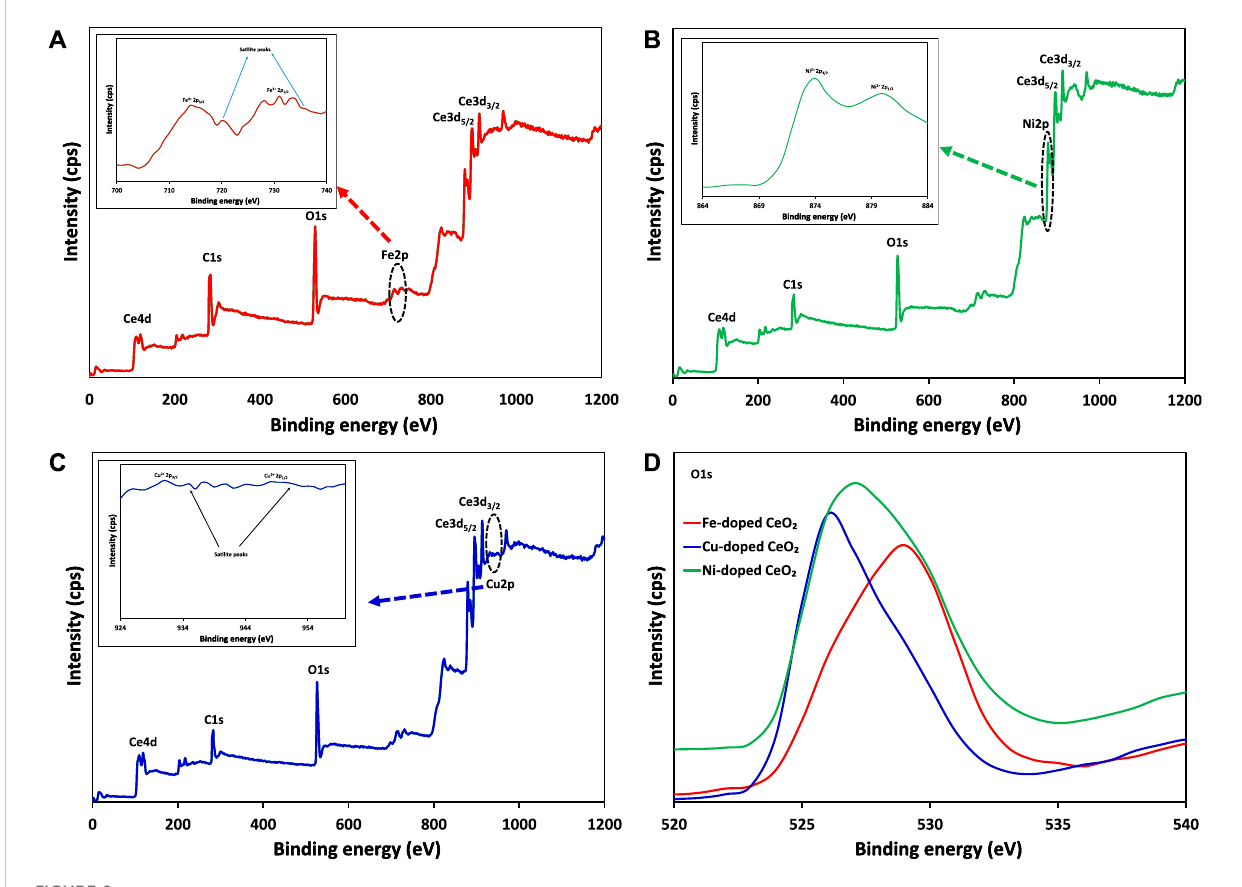
FIGURE 9 The comparison of XPS survey scan of (A) Fe-doped CeO 2 (B) Ni-doped CeO 2 (C) Cu-doped CeO 2 and (D) O1s levels of modi fi ed CeO 2 photocatalysts.